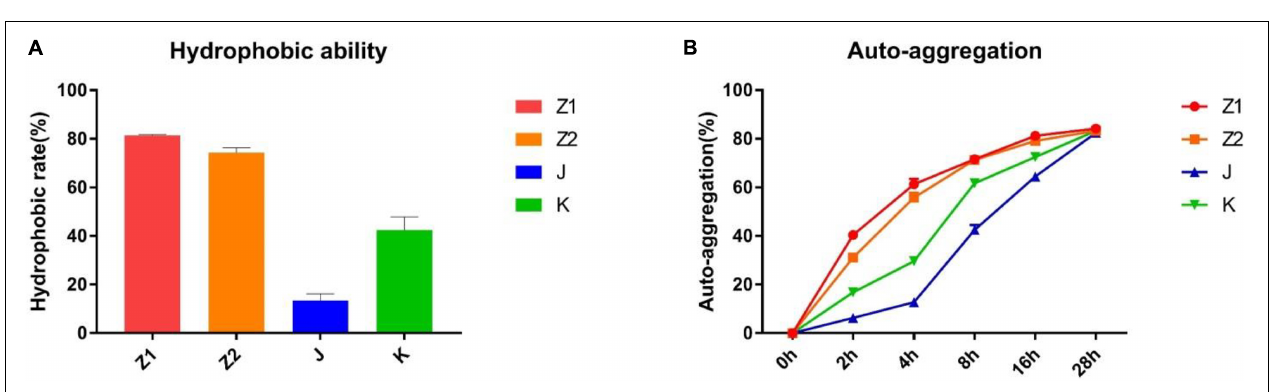
FIGURE 3 | The results of autoaggregation and cell surface hydrophobicity experiment. (A) Hydrophobic ability. (B) Autoaggregation ability.